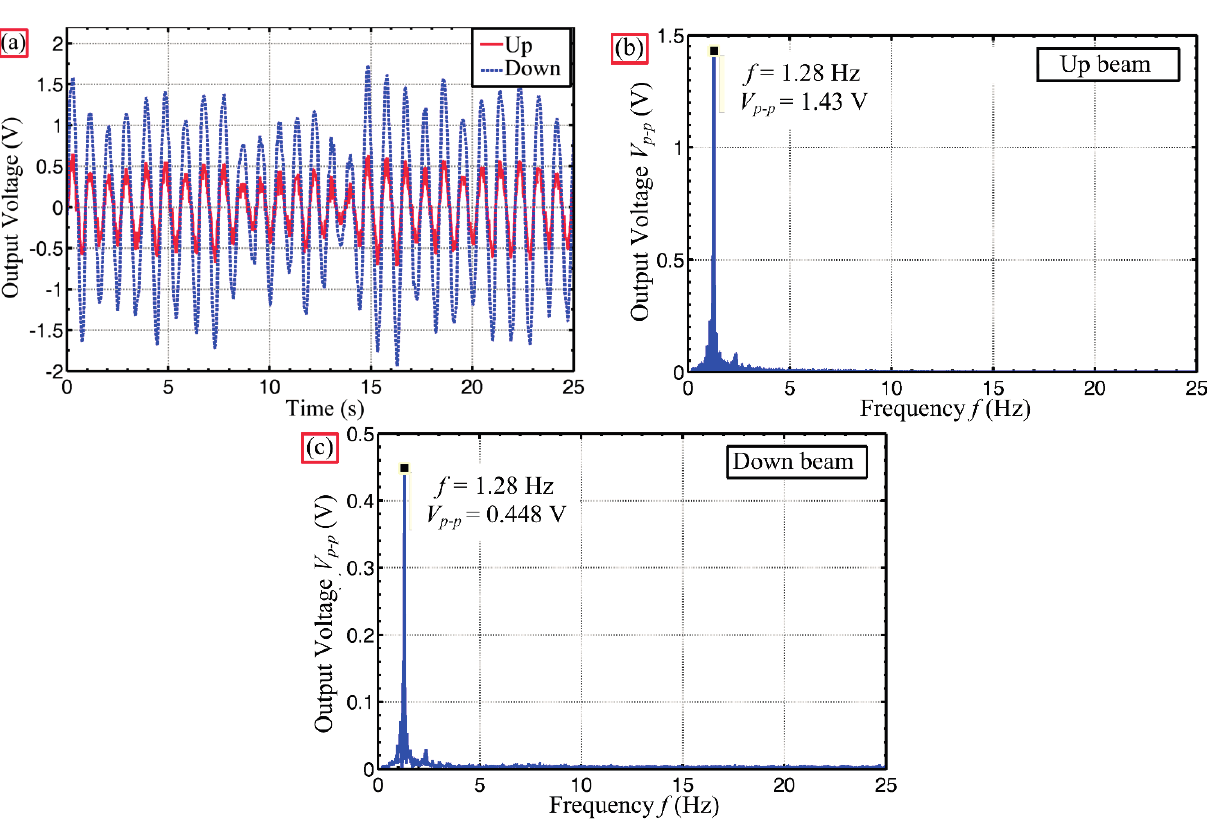
Figure 5. Output voltage and its Fast Fourier Transform (FFT) analysis: ( a ) output voltage of both the upstream and downstream piezoelectric beams as a function of time; ( b ) FFT analysis of the upstream beam; ( c ) FFT analysis of the downstream